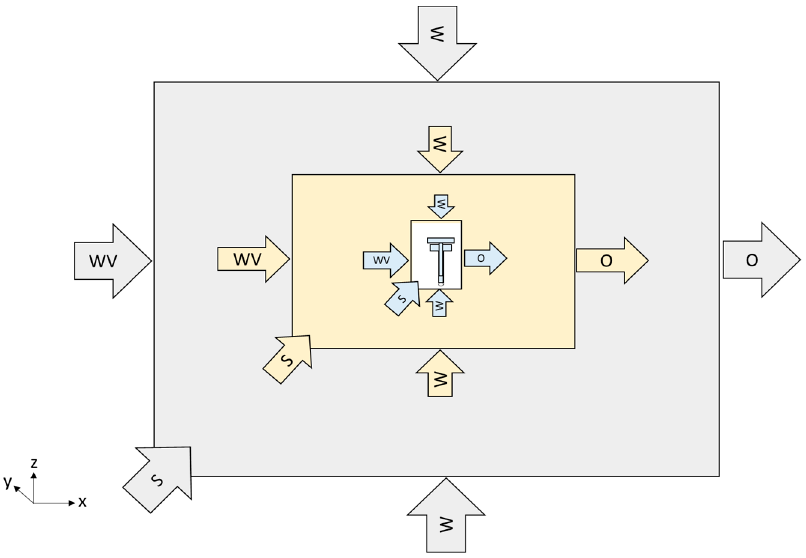
Figure 4. The boundary conditions of the control